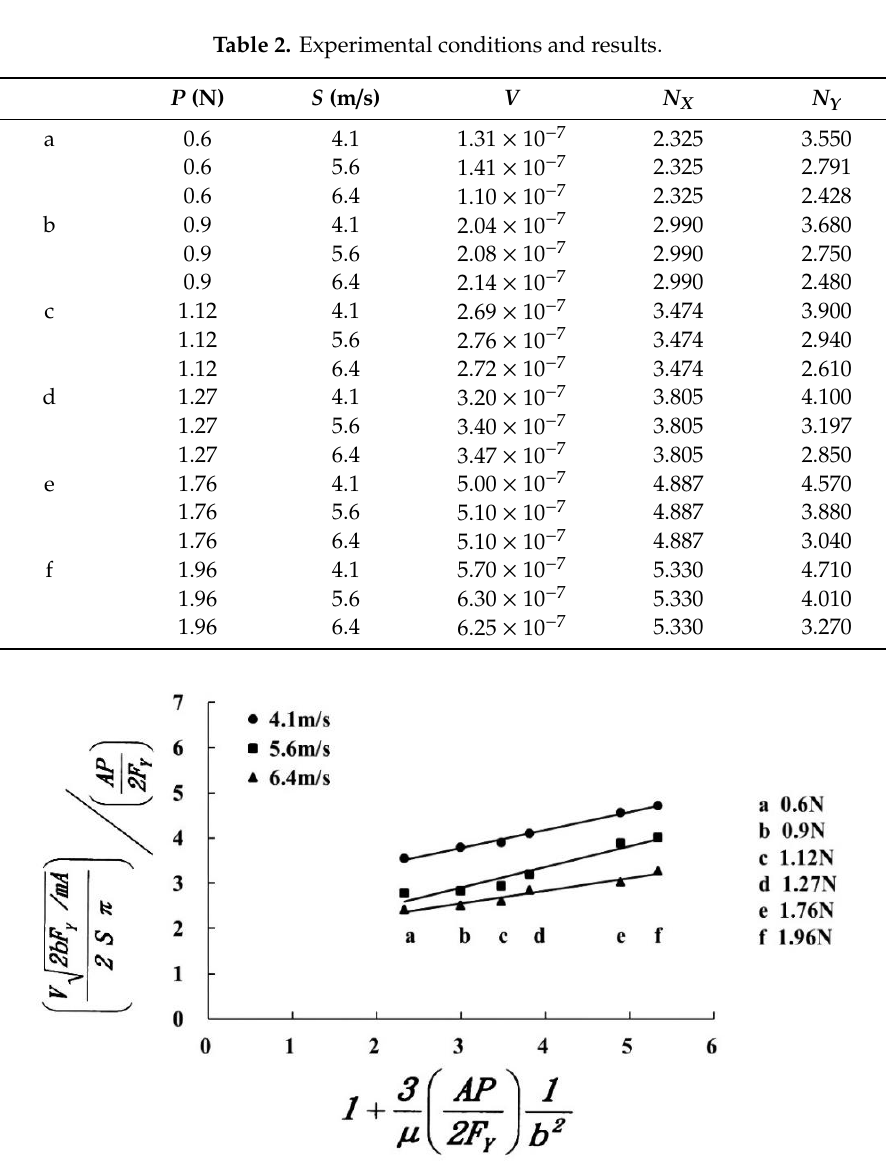
Figure 7. Experimental results for the volume of Al 2 O 3 that is removed.